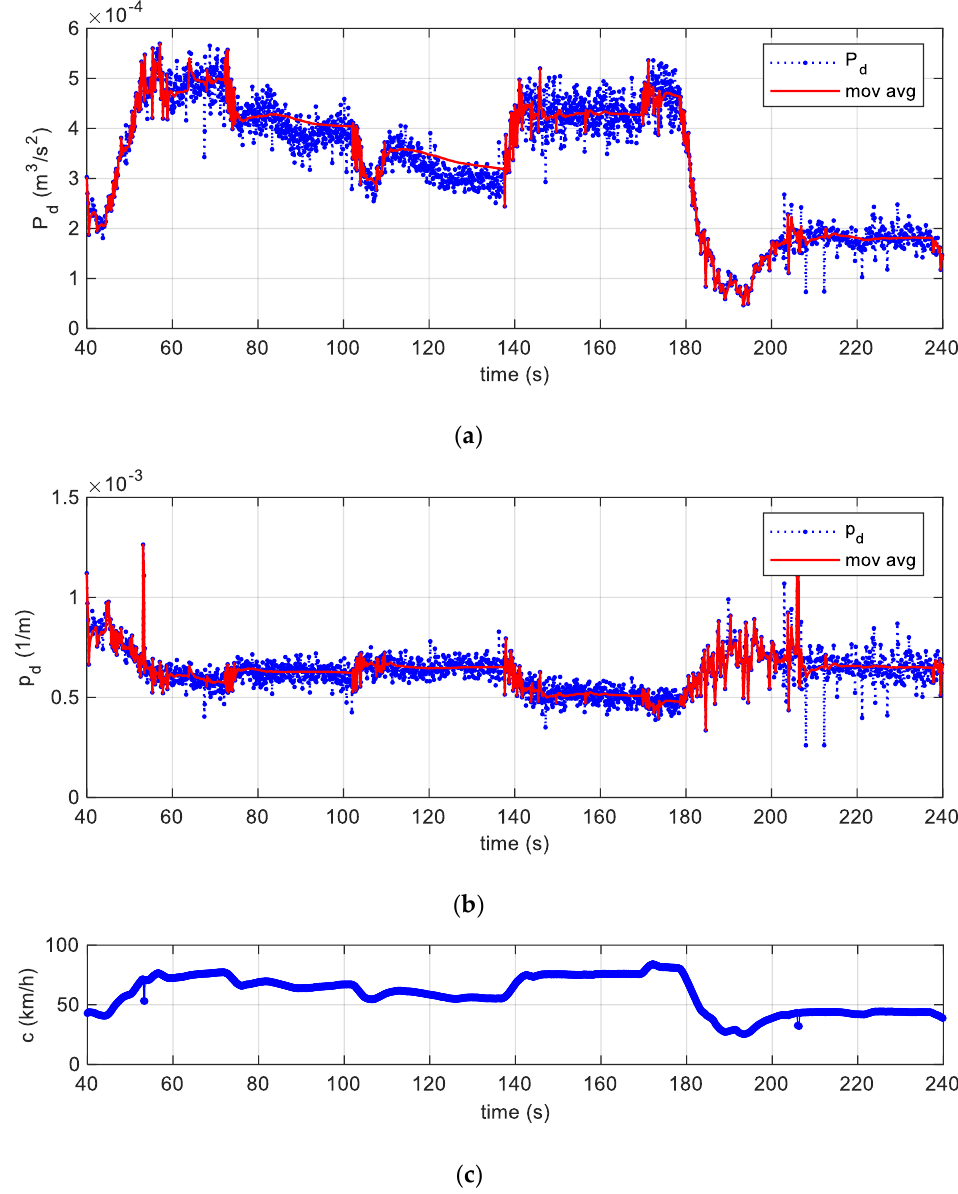
Figure 11. ( a ) The specific dissipated power and its moving average in blue and red lines, respectively; ( b ) the dissipation factor and its moving average; ( c ) the estimated velocity of the centre of the tyre.